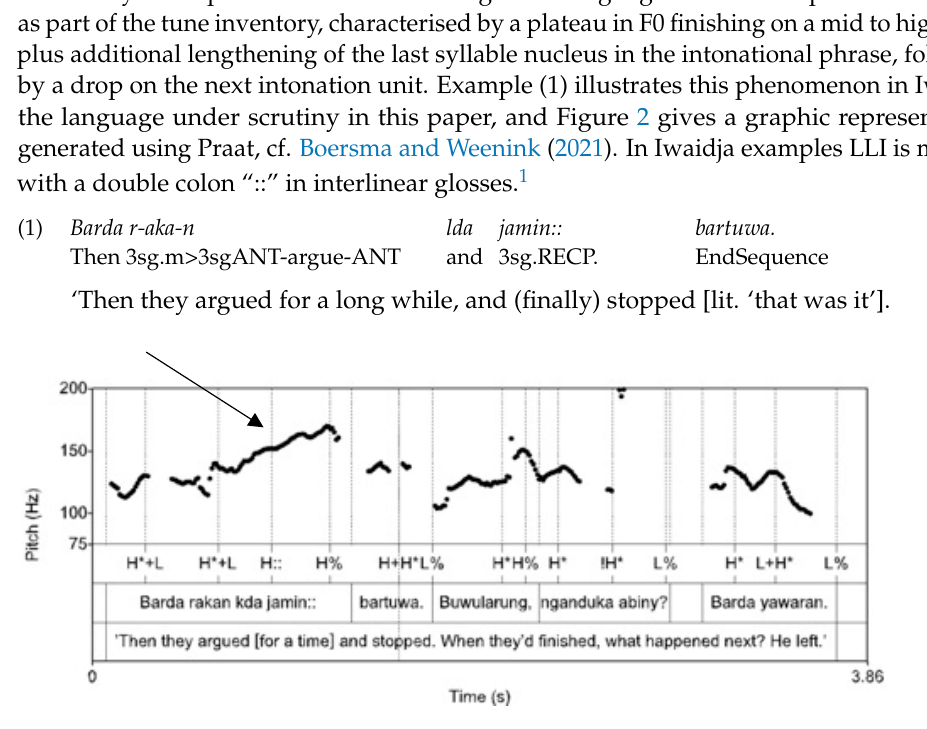
Figure 2. Linear lengthening intonation in Iwaidja, from Mailhammer and Caudal (2019) with added arrow pointing to the relevant section.